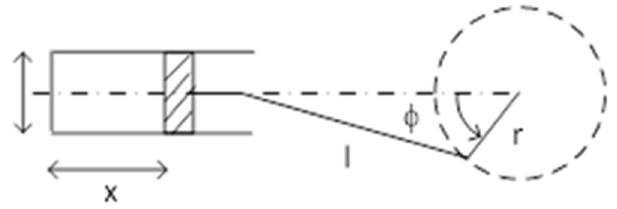
Figure 5. Piston, crankshaft and connecting rod.